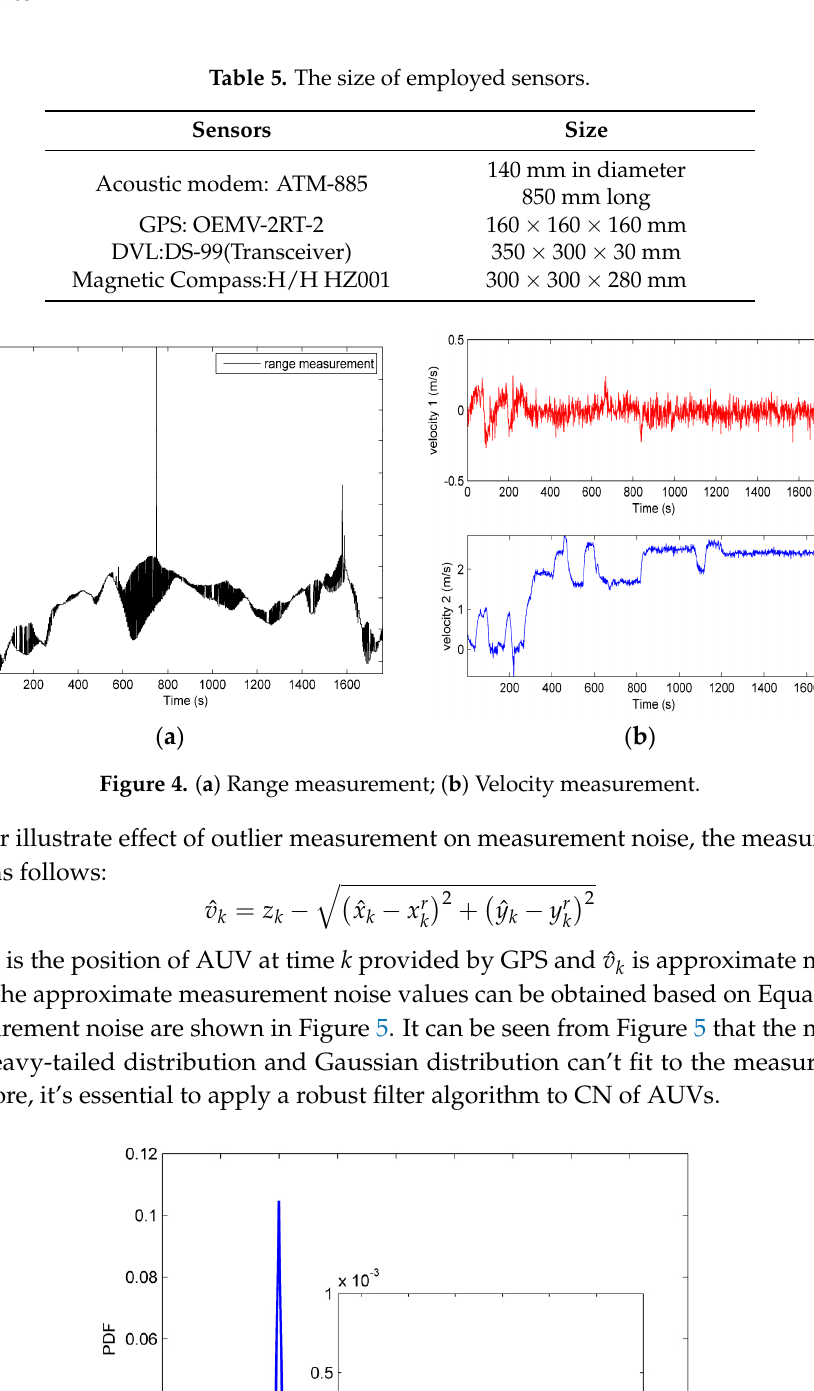
Figure 5. Probability density function (PDF) of measurement noise.